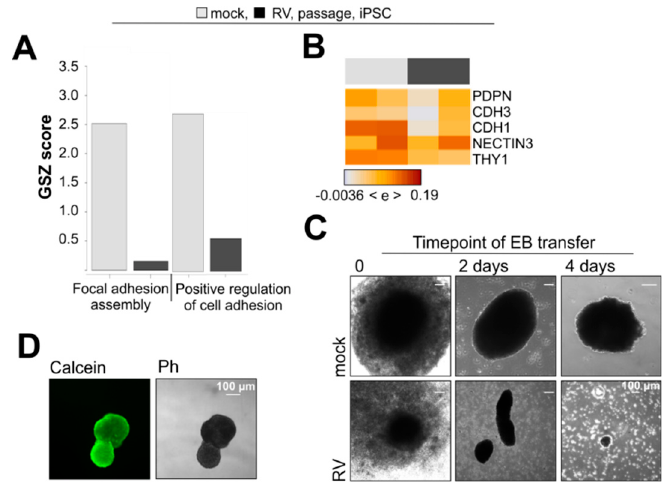
Figure 5. RV impairs the cellular adhesion capacity of iPSCs. ( A ) Gene signatures related to focal adhesion in mock- and RV-infected iPSCs. ( B ) Expression heatmap of selected marker genes involved in cellular adhesion. ( C ) Assessment of 3D stability through embryoid body (EB) formation. Shown are images before and after cultivation in suspension. ( D ) To verify viability, EBs were stained with calcein after cultivation for two weeks.